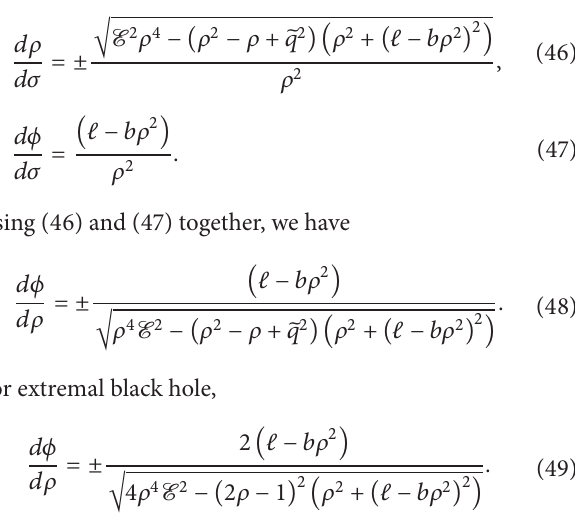
Figure 1: Behavior of angular motion linked with angular momen- tum of the particle.